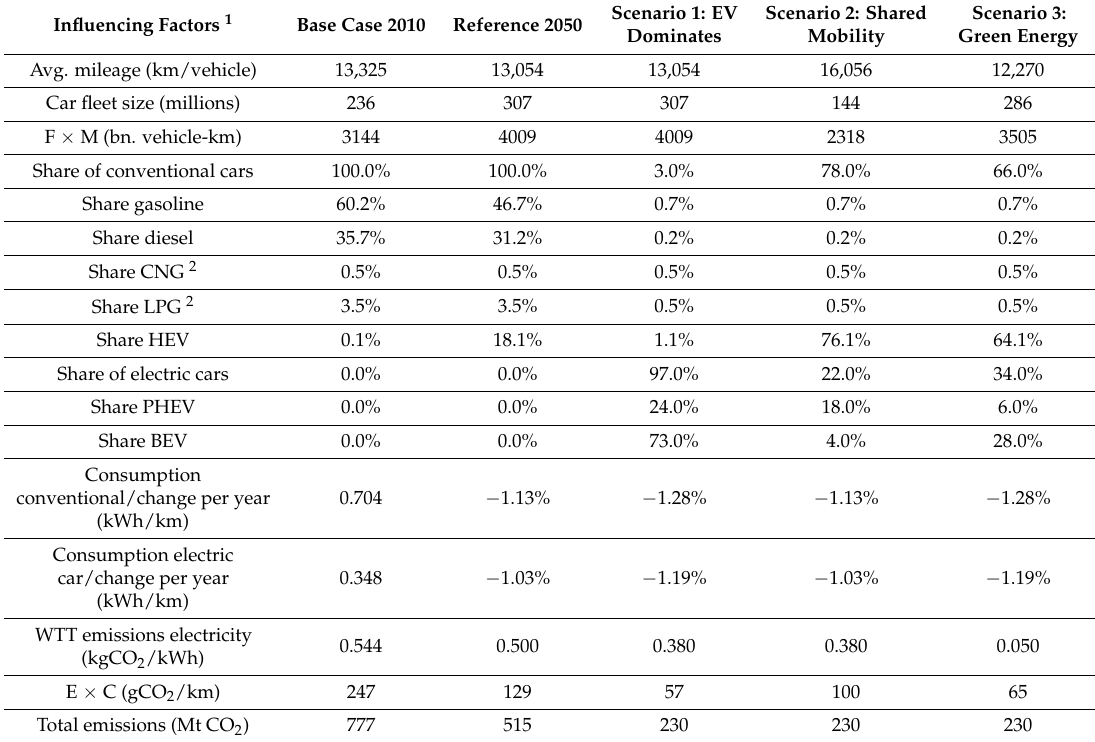
Table 4. Results for